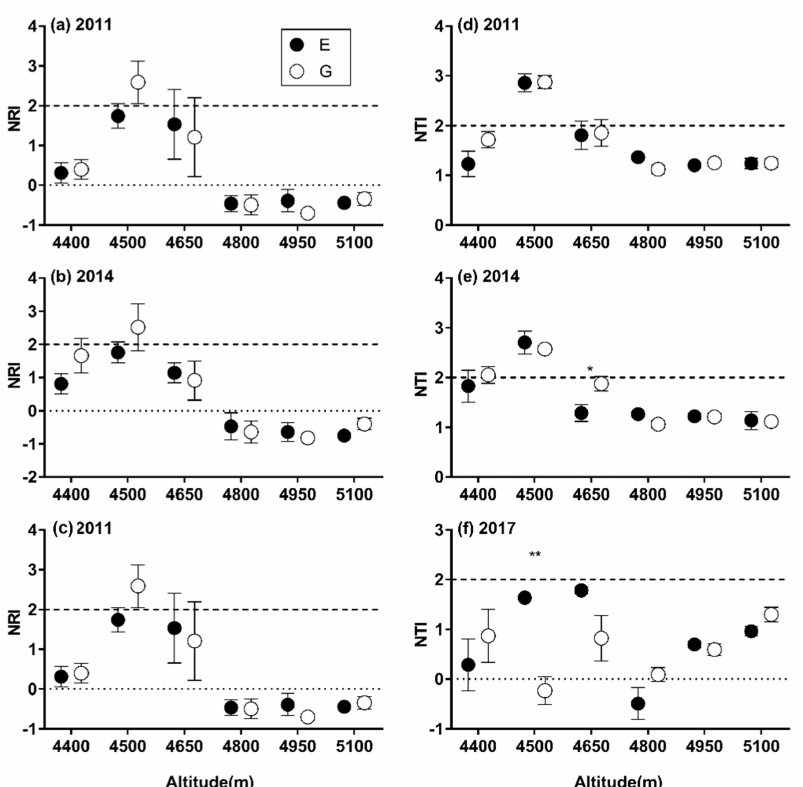
Figure 5. Differences in ( a – c ) net relatedness index (NRI) and ( d – f ) nearest taxon index (NTI) between enclosure and grazing along the altitudinal gradient among different years. Solid and blank circles are for enclosure and grazing plots, respectively. Asterisk denotes the significant difference between enclosure and grazing. Dashed and dotted line denote an NRI or NTI value of 2 and 0, respectively. * P < 0.05, ** P < 0.01, *** P <